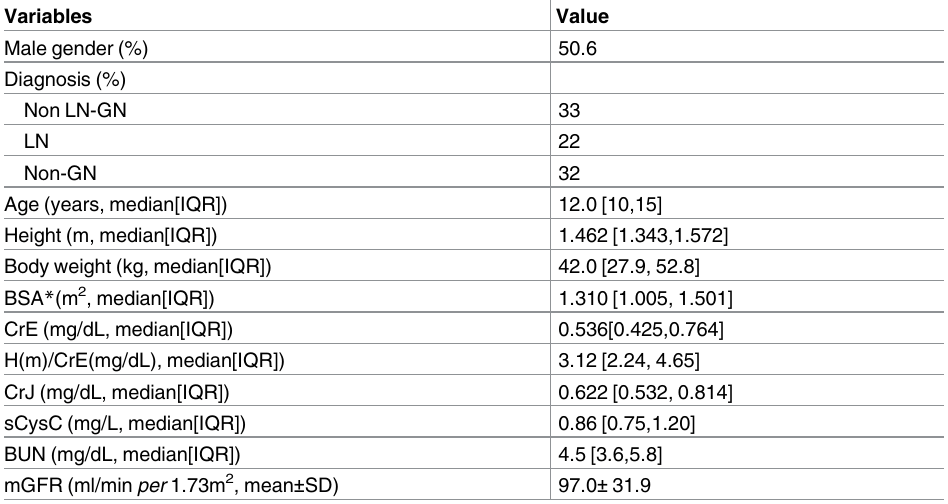
Table 2. Clinical characteristics of the study